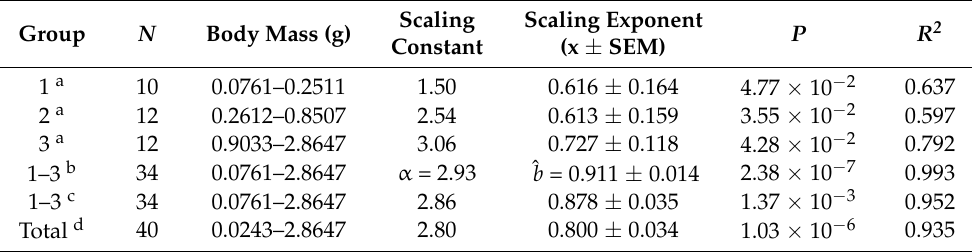
Table 1. Summary of intragroup (rows 1–3) and intergroup (rows 4–6) regression analyses of the relationship between log VO 2 ( VO 2 in µ L of O 2 fish − 1 min − 1 ) and log M ( M in g) in F 2 bester at 20 ◦ C. N , number of individuals; P , scaling exponent difference from unity (two-tailed Student’s